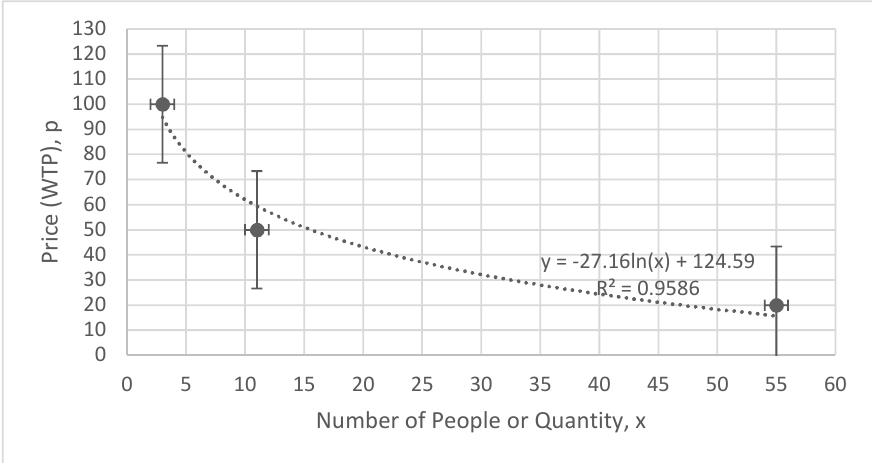
Figure 2. Willingness-to-pay (WTP) for Facebook.